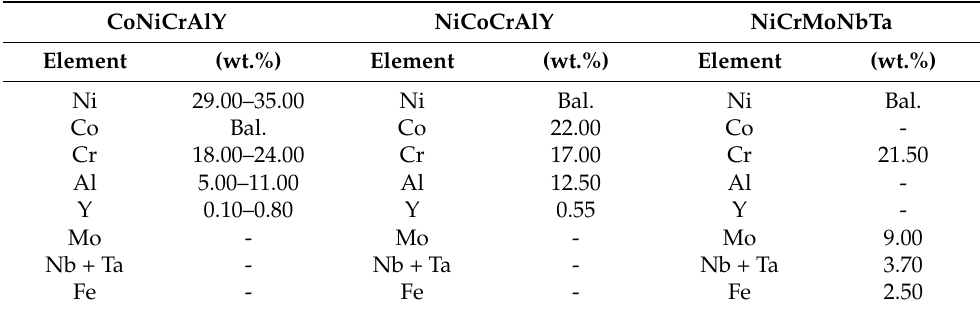
Table 2. Nominal chemical composition of feedstock powders used for HVOF